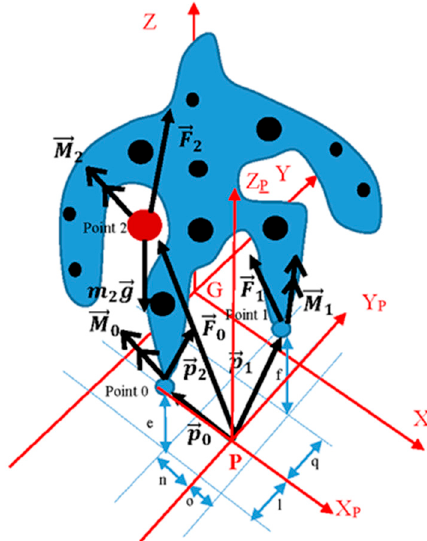
Figure 1. Scheme for determining the total CoM (Center of Mass) position. The direction of the force and torque vectors is only indicative. Points 0 and 1 represent the feet, where the force/torque sensors are positioned; the center of mass is represented with the Point 2; the other black points indicate the mass of the links of the robot.